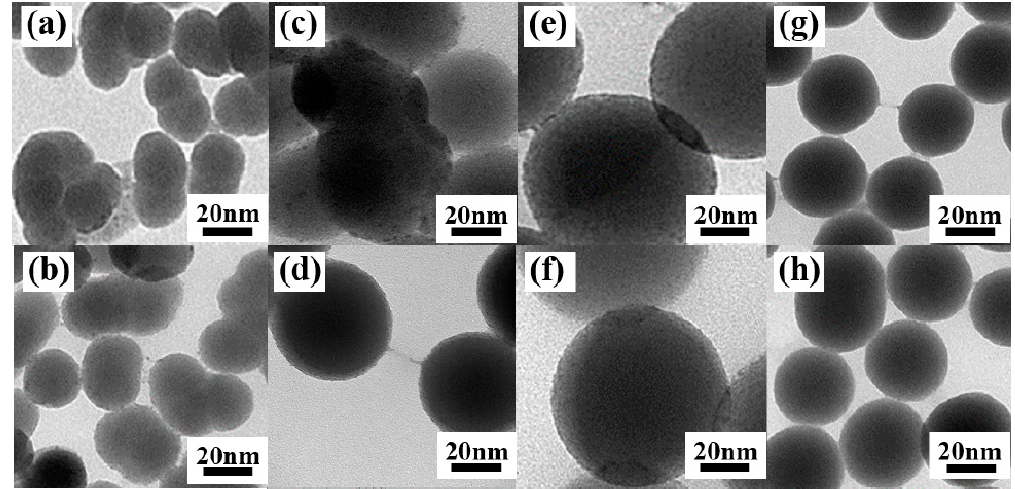
Figure 8. SiO 2 -Tm(DBM) 3 phen with a diameter of ( a ) 25 nm, ( c ) 50 nm, ( e ) 80 nm, and ( g ) 40 nm; SiO 2 -Tm(TTA) 3 phen with a diameter of ( b ) 25 nm, ( d ) 50 nm, ( f ) 80 nm, and ( h ) 40 nm.